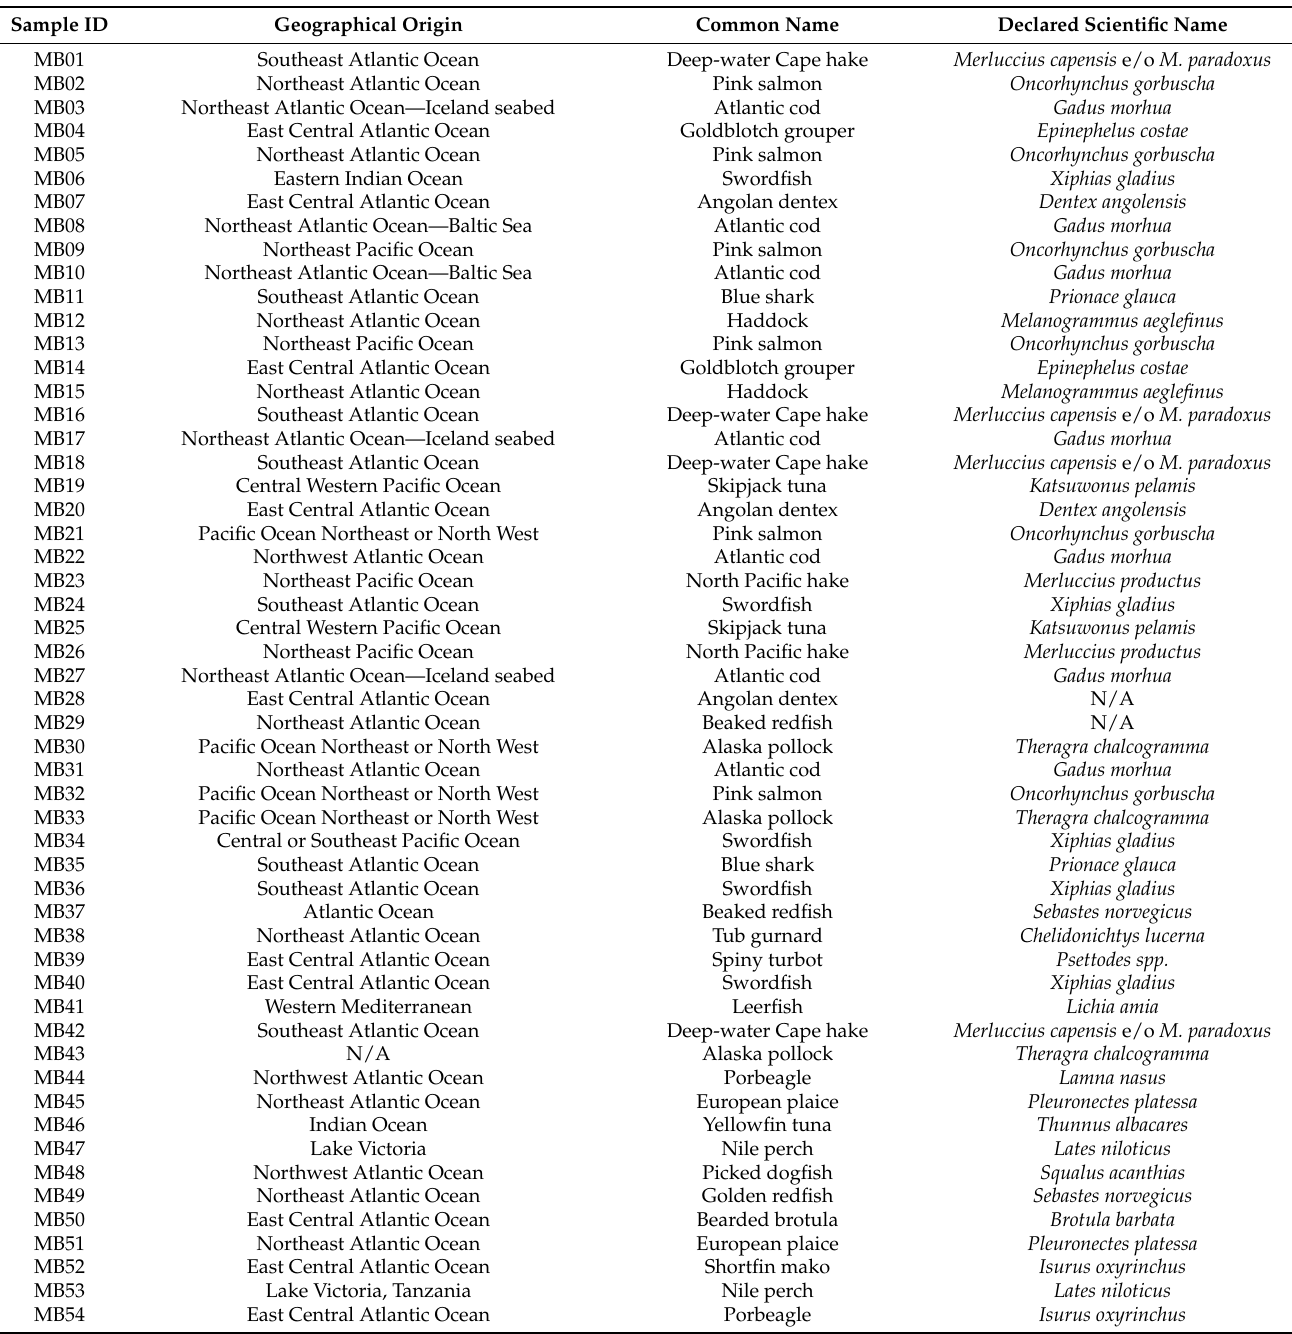
Table 1. Detailed description of analyzed samples and information reported in the labels (common name, declared scientific name and fishing area). “N/A” (not available) refers to lacking label